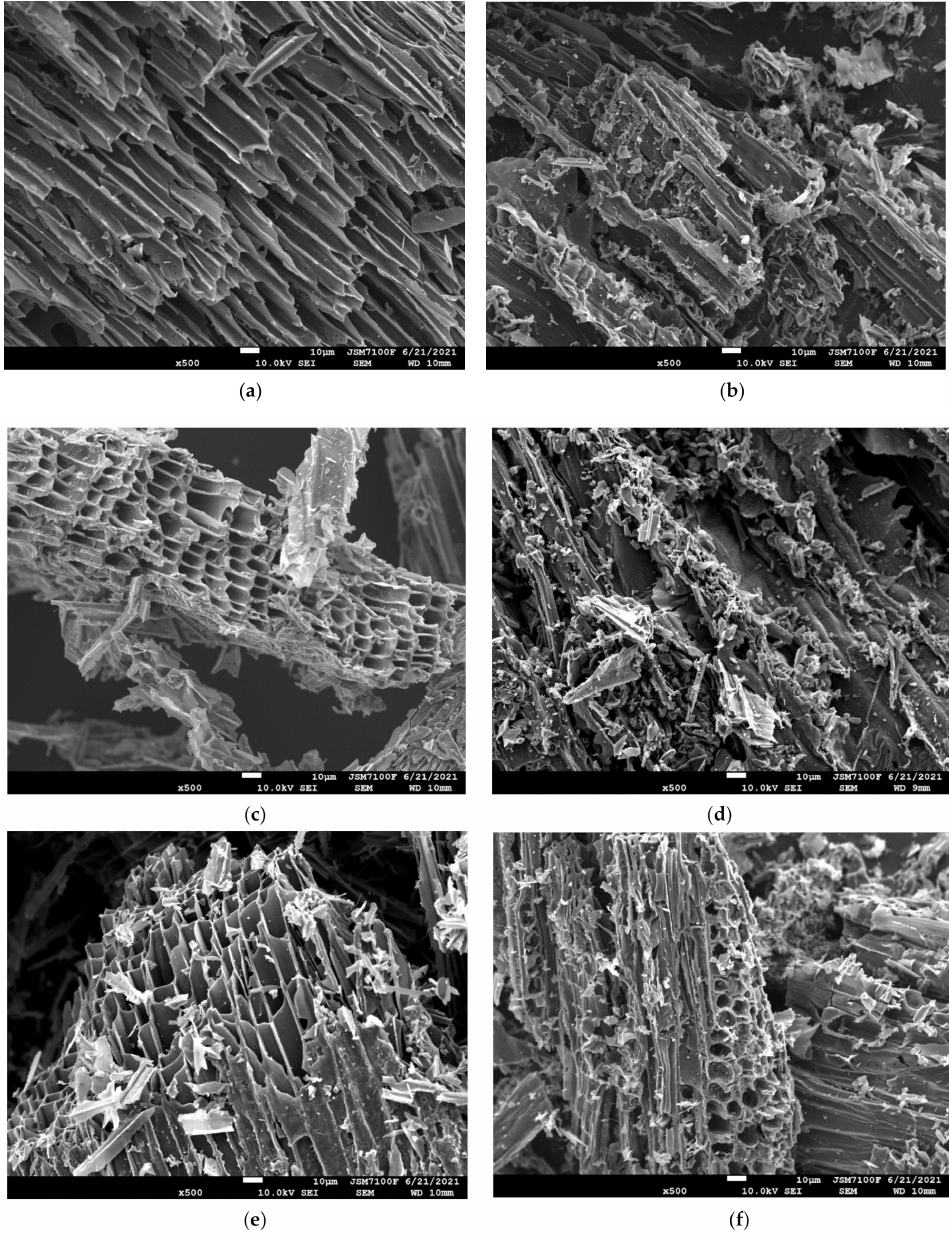
Figure 4. SEM image of flax and beech biochars at untreated, citric acid-treated (CA), and thermally treated forms, magnification: 500 × . ( a ) Flax shives biochar non-treated, ( b ) Beech wood biochar non-treated, ( c ) Flax_shives biochar Citric Acid treated, ( d ) Beech_wood biochar Citric Acid treated, ( e ) Flax_shives biochar_heat_oxid (at 250 ◦ C), ( f ) Beech_ wood biochar_heat_oxid (at 250 ◦